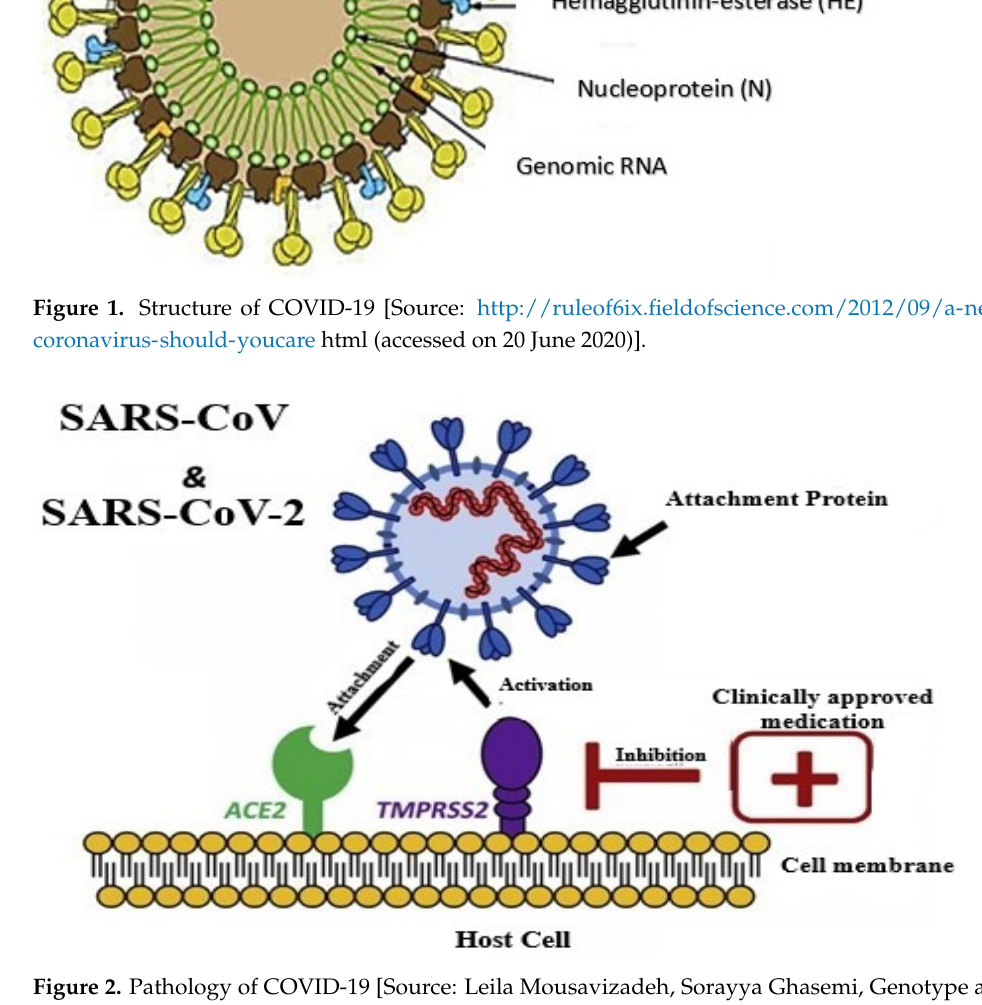
Figure 2. Pathology of COVID-19 [Source: Leila Mousavizadeh, Sorayya Ghasemi, Genotype and phenotype of COVID-19: Their roles in pathogenesis. Journal of Microbiology, Immunology and Infection. 2020].